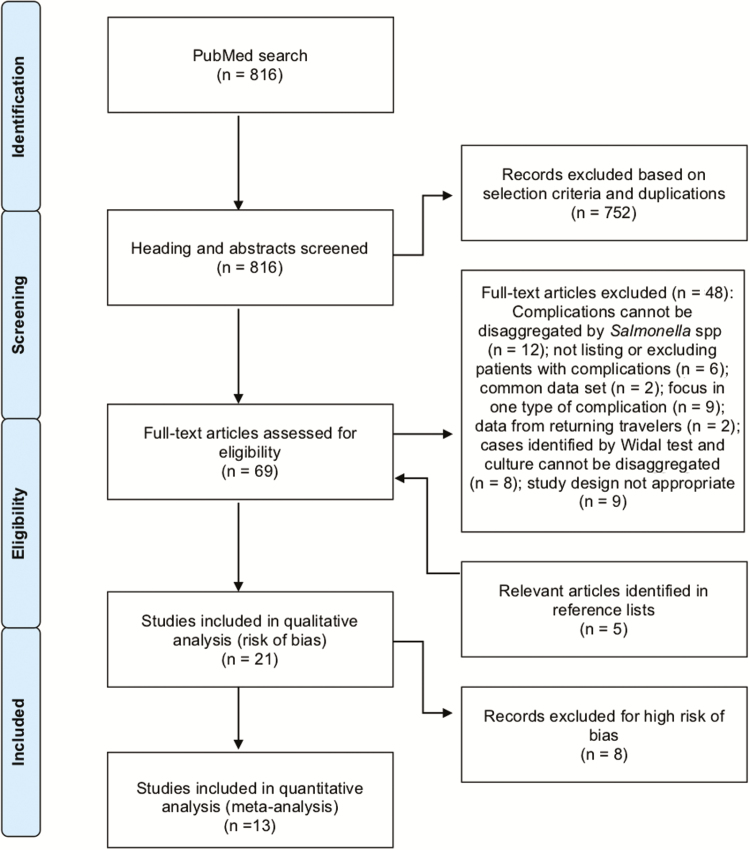
Study selection flow diagram (1990–2018).